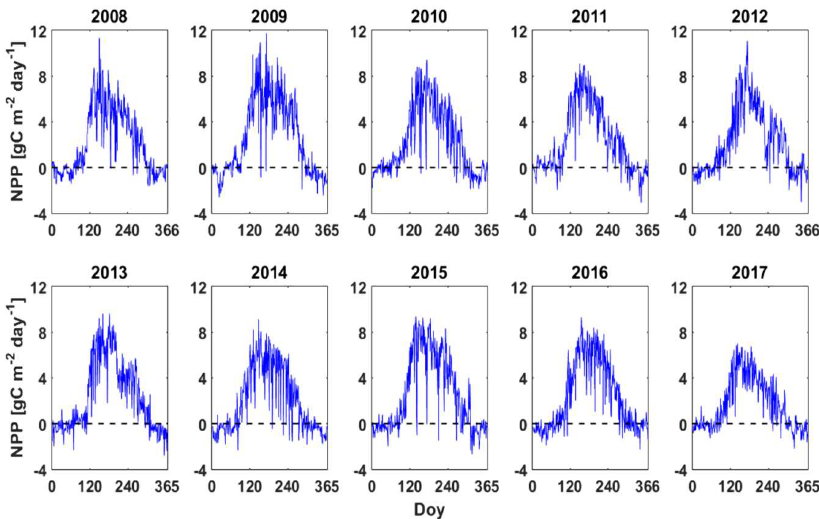
Figure 9. Daily values of NPP EC in Jastrebarsko forest during 2008–2017.